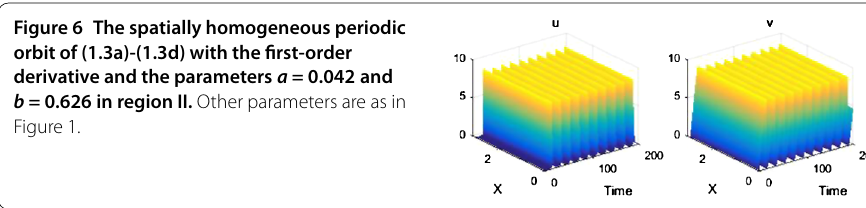
Figure 5 The spatially homogeneous periodic orbit of (1.3a)-(1.3d) with the parameters a = 0.042 and b = 0.626 in region II. Other parameters are as in Figure 1.